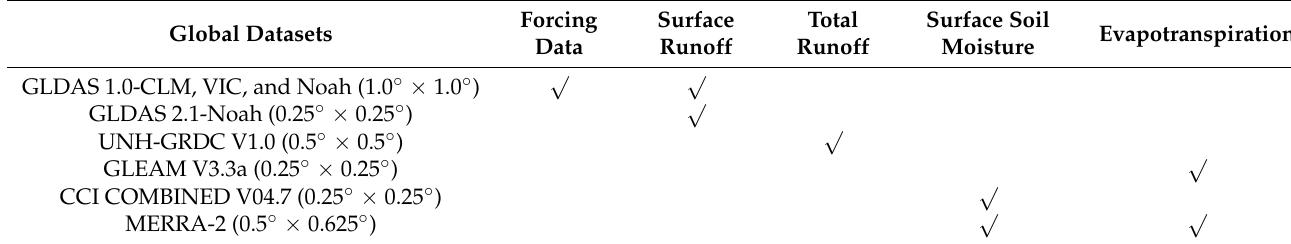
Table 1. Datasets used in this